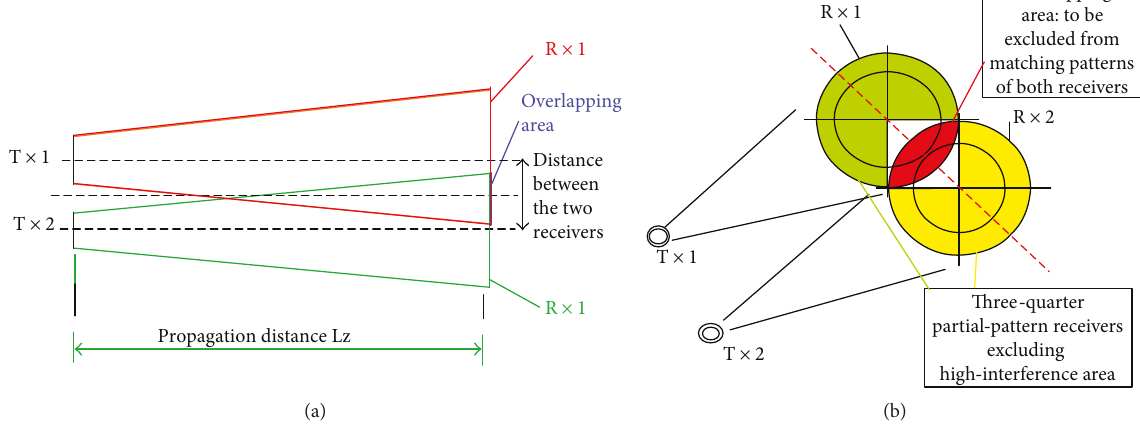
Figure 5: (a) Two transmitters (Tx1, Tx2) with overlapping beams at the receivers (Rx1, Rx2). (b) Schematic for two overlapping beams where we exclude the largest interfering quarter of the matching pattern to maximize the achieved rate. Rx1 will be only the green area, and receiver 2 will be the yellow